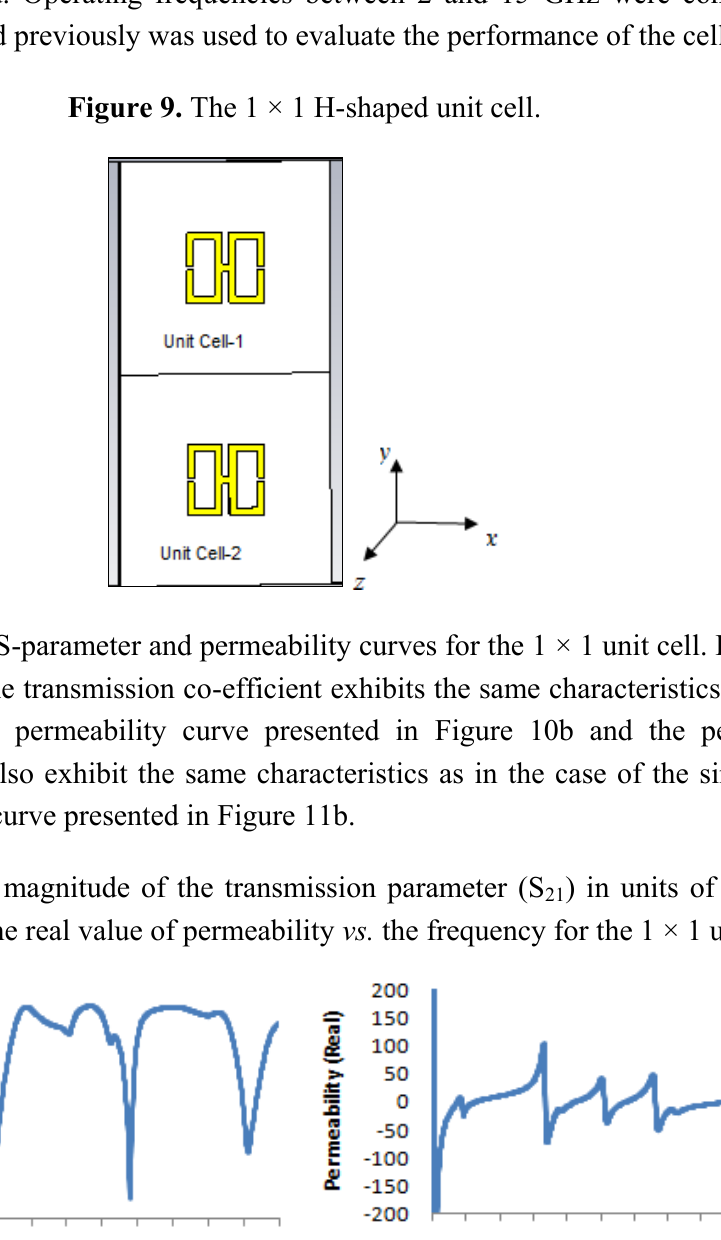
Figure 10. ( a ) The magnitude of the transmission parameter (S